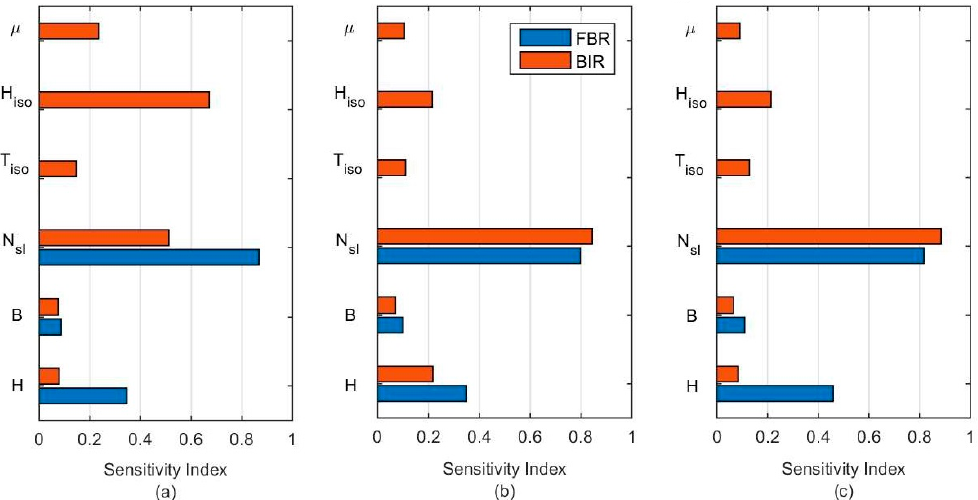
Figure 10. Sensitivity indices. ( a ) maximum base shear load, ( b ) maximum drift and ( c ) maximum displacement of the top storage level.